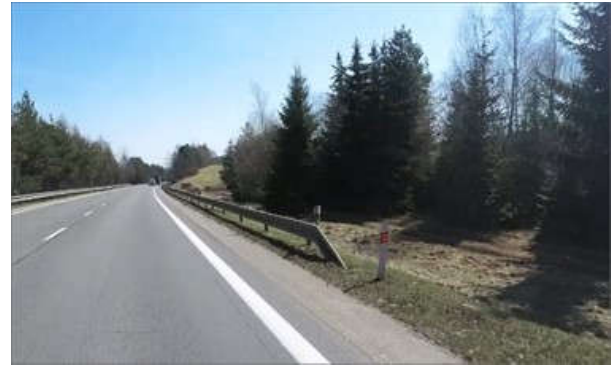
Figure 1. Short turned down end of the crash barrier.